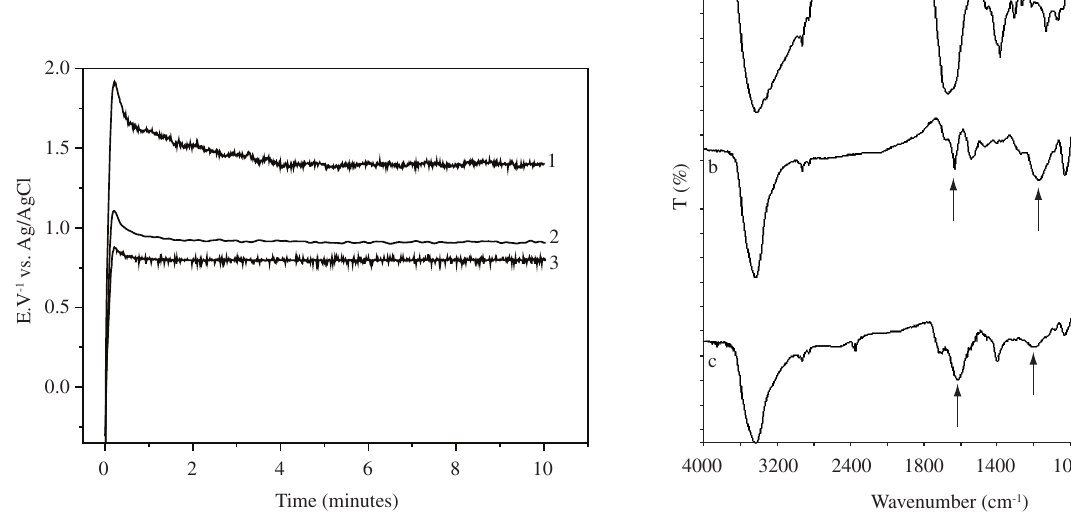
Figure 1. Potential transient for PPy electrodeposition on aluminum surfaces from aqueous solutions containing 0.5 mol.L -1 pyrrole and 0.2 mol.L -1 of each electrolyte: 1) citric acid; 2) tartaric acid; and 3) oxalic acid.